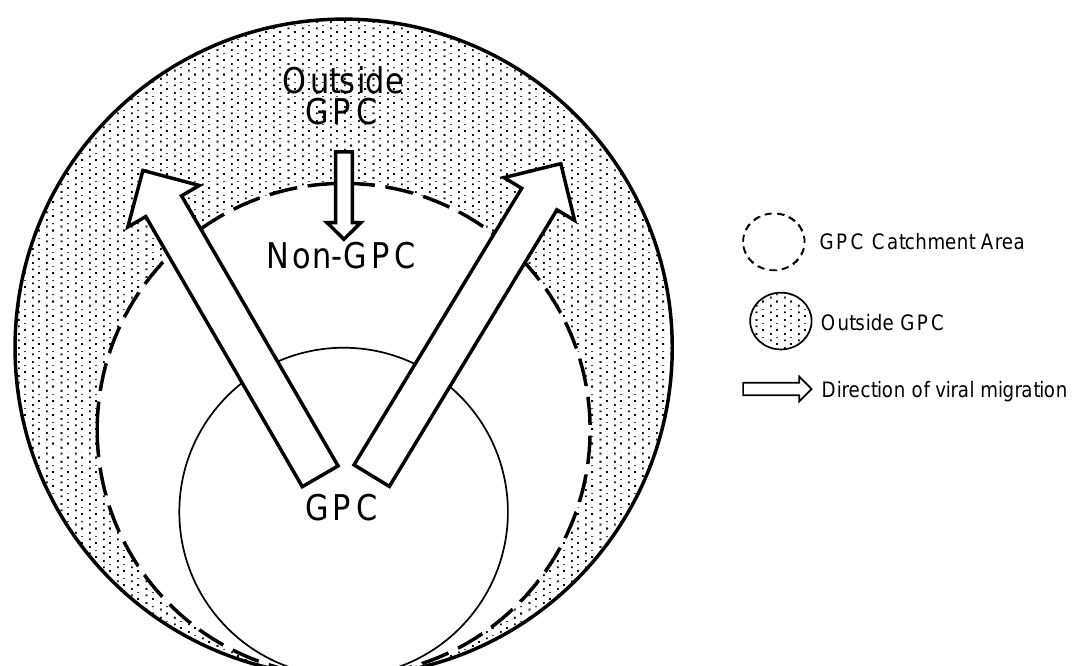
Figure 2. Schematic showing the viral diffusion in the GPC and other external locations. The patterns of virus flow in these communities suggests significant dissemination (BF > 3) of viral lineages mostly outwards and away from the GPC into other areas located outside the GPC with no substantial viral migration (BF < 3) into the GPC. The thicker arrows represent very strong support for viral dissemination (BF > 100) from the GPC while the smaller arrow indicates viral introductions from areas outside the GPC. The size of the arrows is proportional to the level of support for viral diffusion with the thicker arrows indicating stronger support.